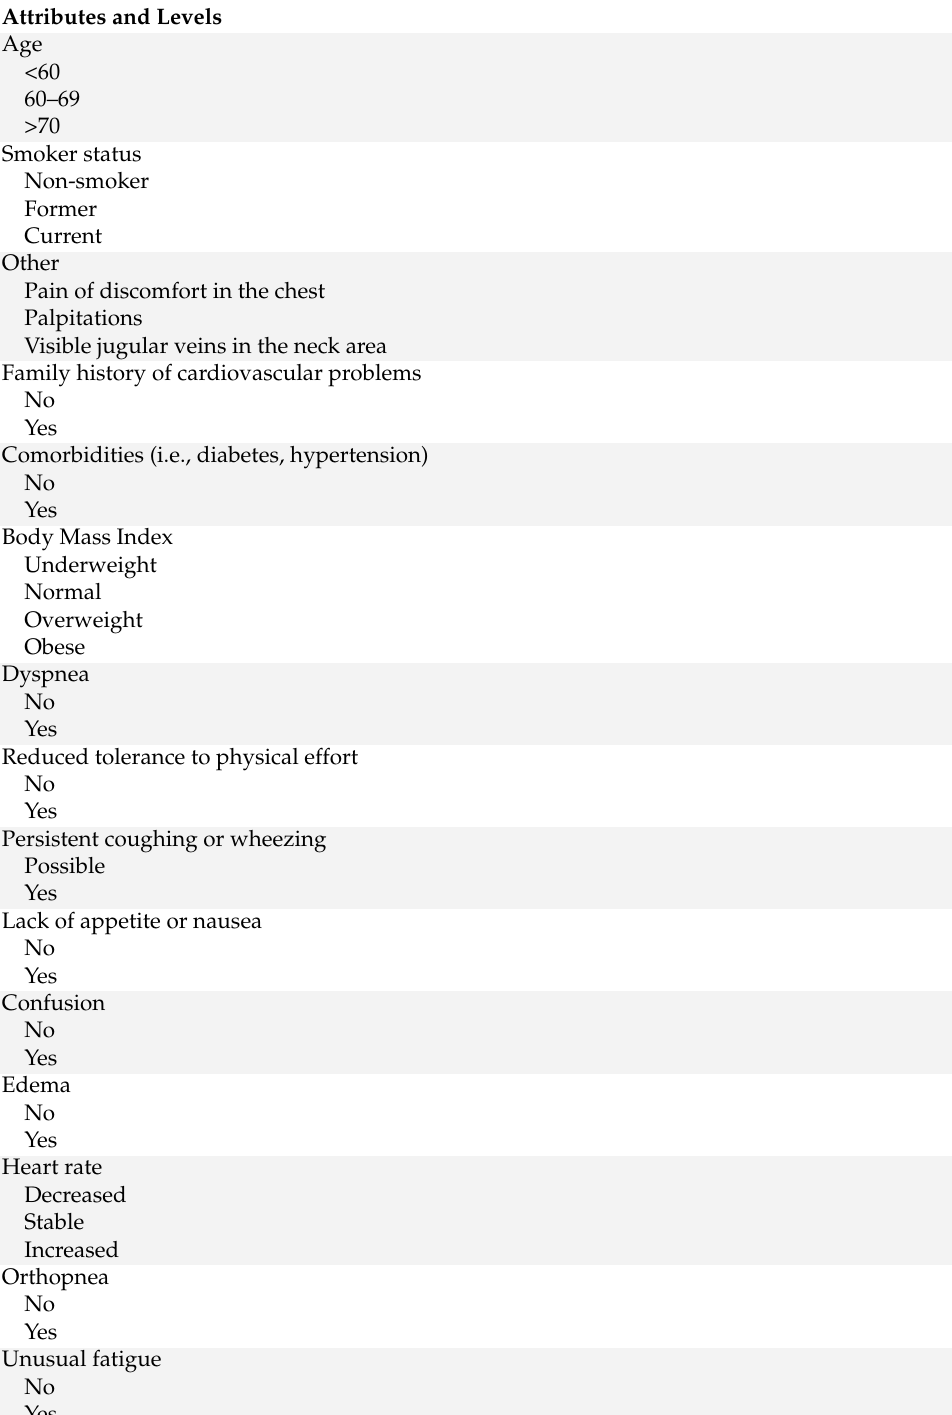
Table 2. Attributes and levels for heart failure diagnosis—clinical